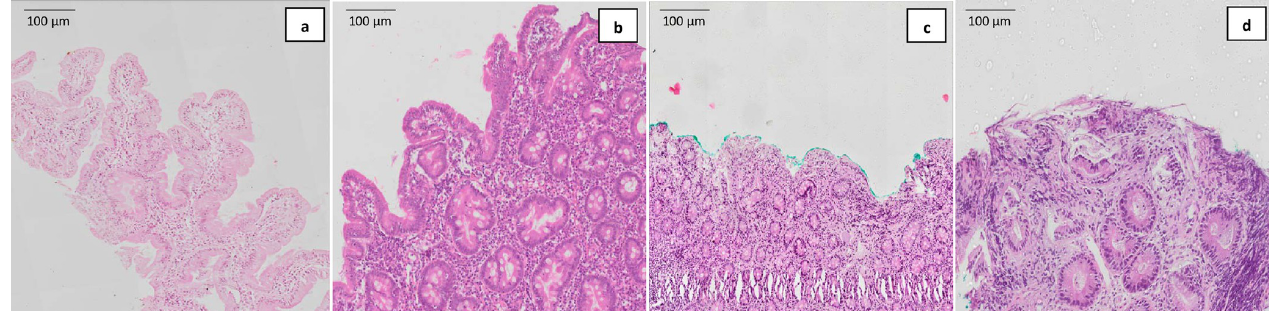
Fig 1. Representative histological images of villous height obtained using hematoxylin and eosin (H&E) stain.